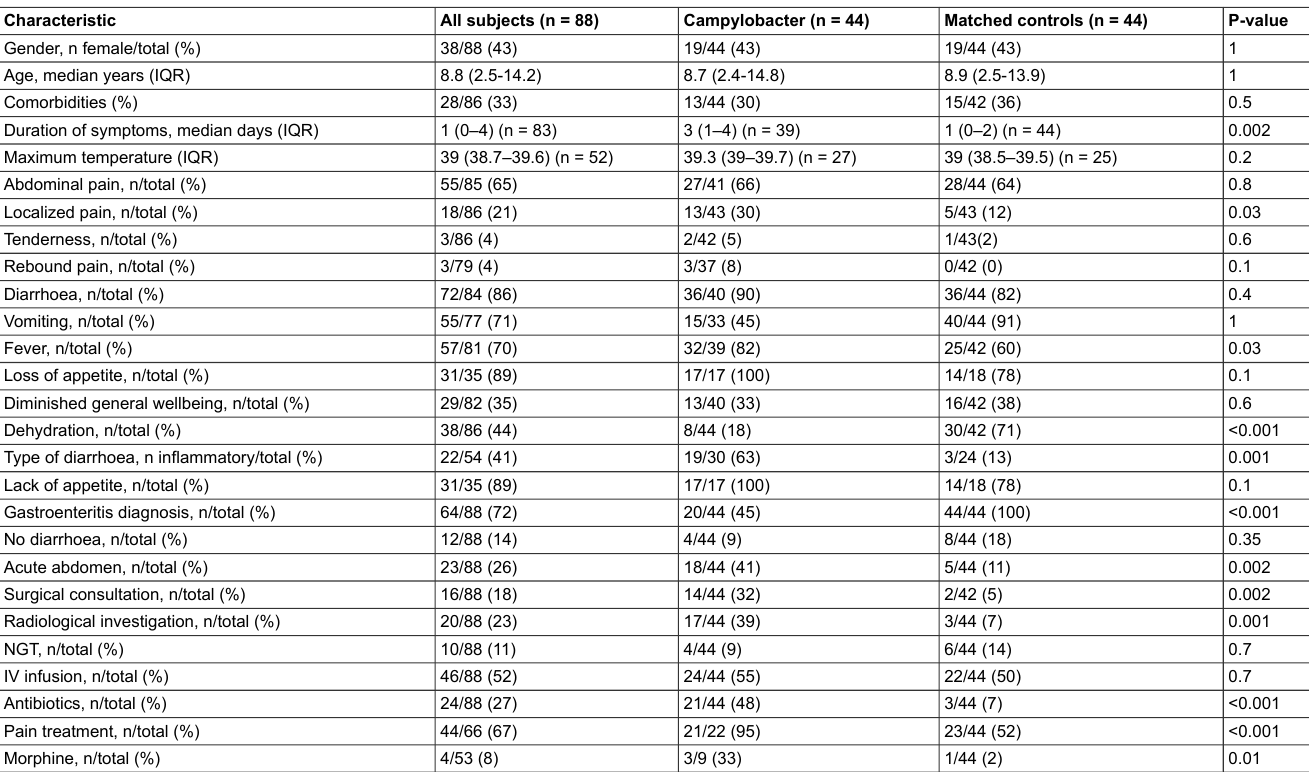
Table S1: Comparison of hospitalised CSE patients with matched